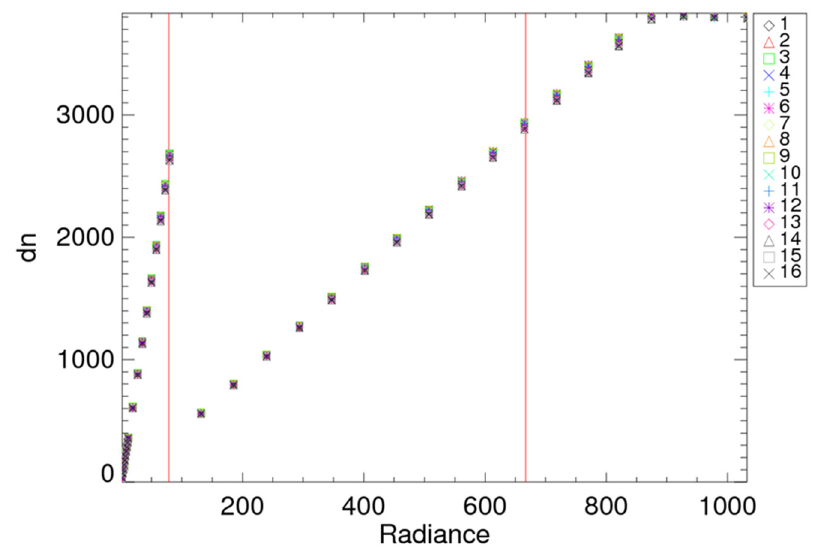
Figure 6. Band M4 dynamic range measurements for all detectors, legend in the upper right, for HAM side B. The points to the left of the first vertical line are high gain measurements. The band switches to low gain after a radiance of 40. The first and second vertical red lines are for high and low gain Lmax, respectively. The y -axis is offset subtracted VIIRS response, and the x -axis is the SIS100 radiance during the